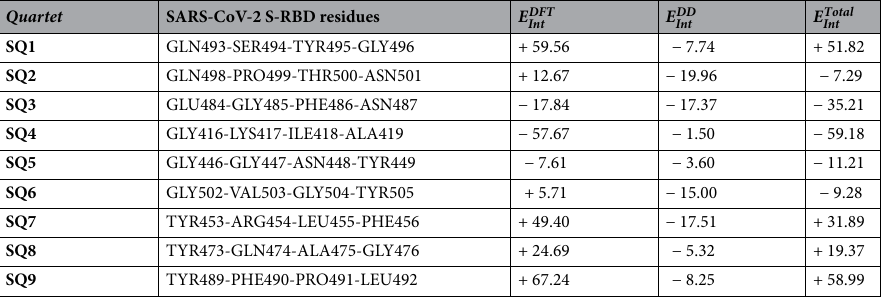
Table 2. SARS-CoV-2 S-RBD quartets and their interaction energies [kcal/mol] a with neighboring b hACE2 residues. a DFT energies computed at 6-311+G(d,p)/B3LYP level; Dispersion (DD) corrections evaluated with